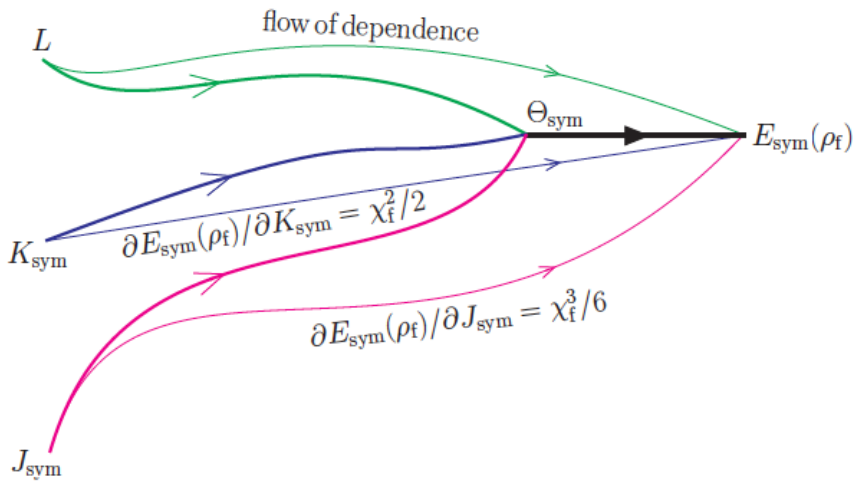
Figure 20. Illustration of how the characteristics L , K sym , and J sym of symmetry energy at ρ 0 affect both directly and indirectly through the parameter Θ sym the high-density symmetry energy at ρ f